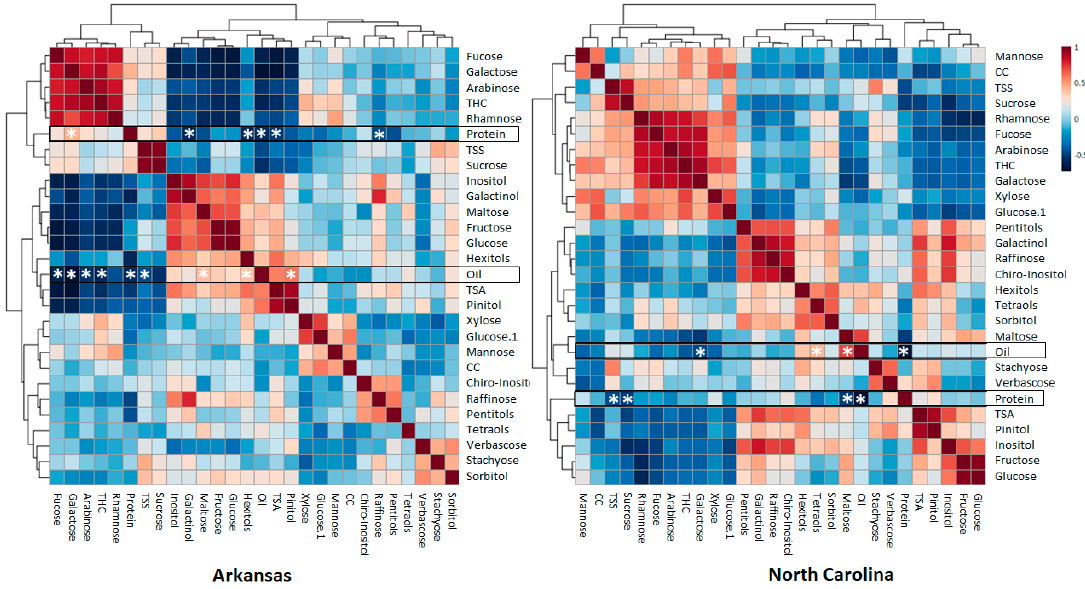
Figure 5. Pearson’s correlation analysis. The analysis was performed separately for each location. Metabolites that significantly correlate with oil and protein are indicated with a white star ( p < 0.05, n = 3). Glucose.1: glucose from matrix polysaccharide, TSS: total soluble sugars, TSA: total sugar alcohols, THC: hemicellulose components, CC: crystalline cellulose.